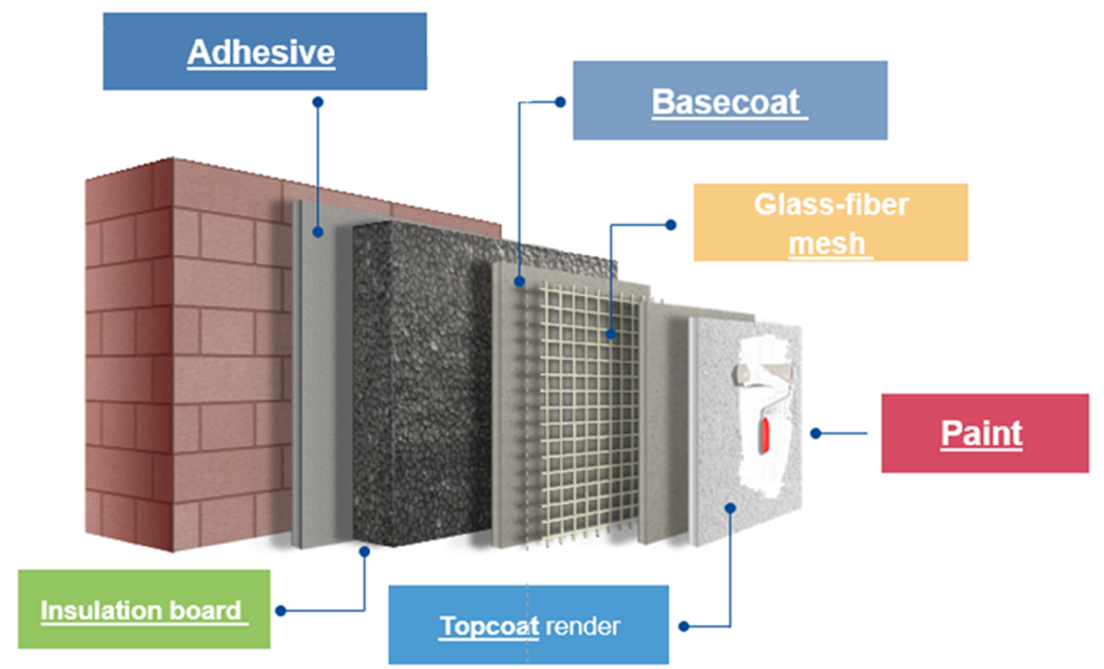
Figure 11. EIFS system with all components. The topic of this section is the topcoat render.